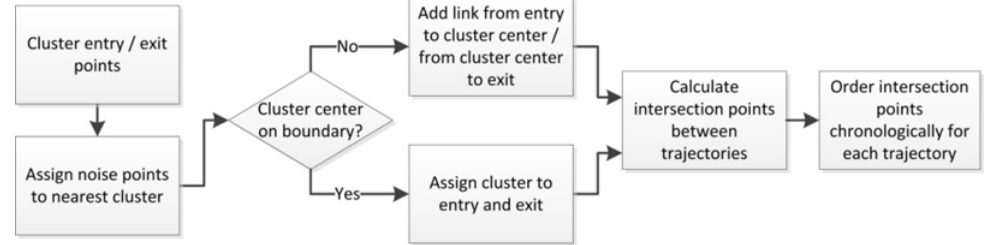
Figure 2. Pre-processing (step A).